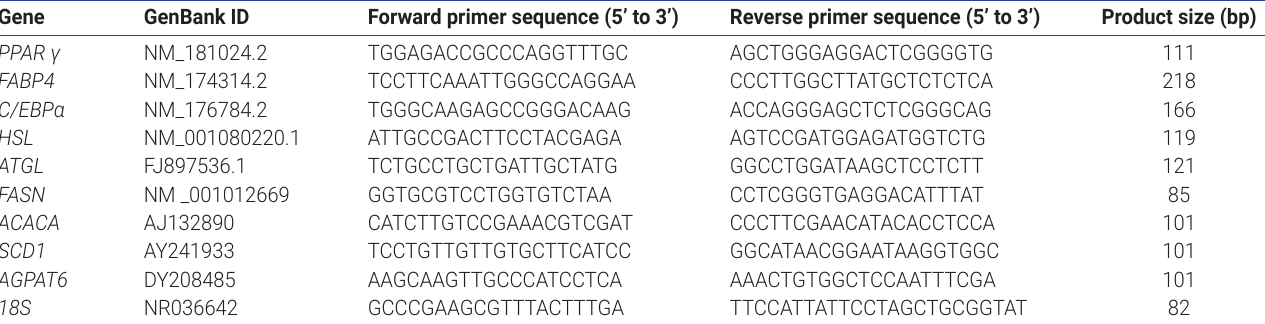
Table 2. Sequences of primers used in quantitative polymerase chain reaction